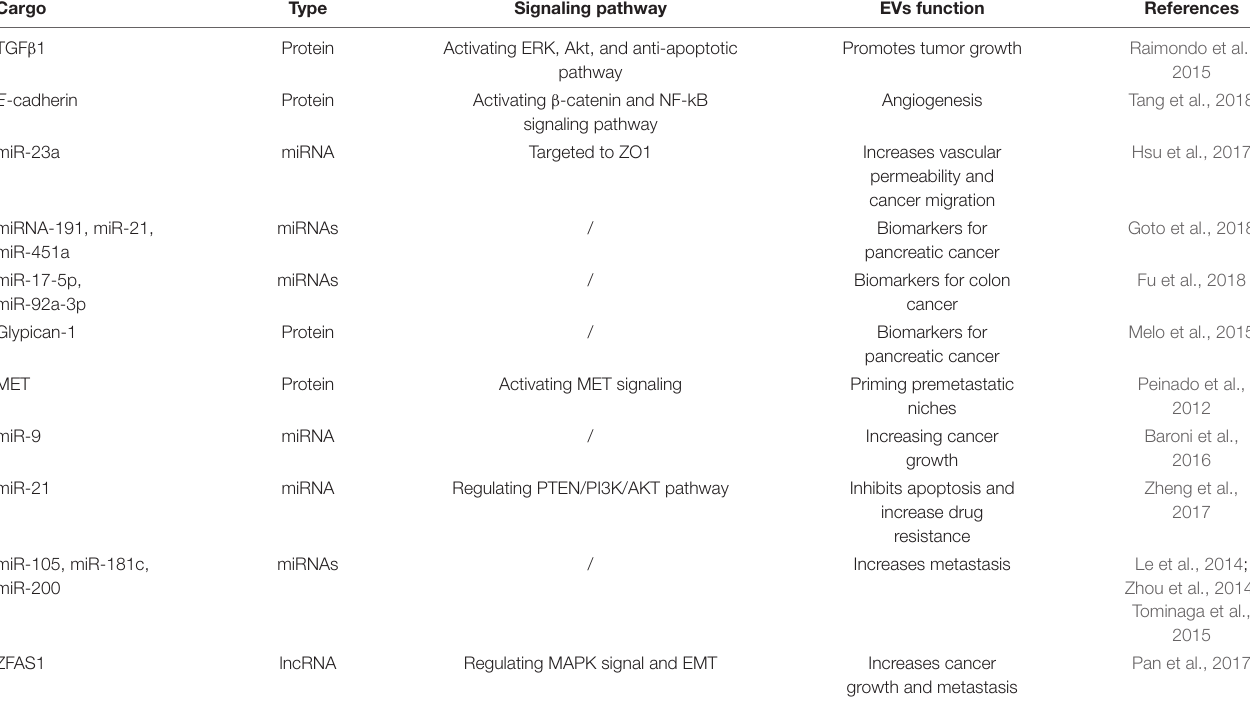
TABLE 1 | Potential exosomal biomarker and targets in a clinical